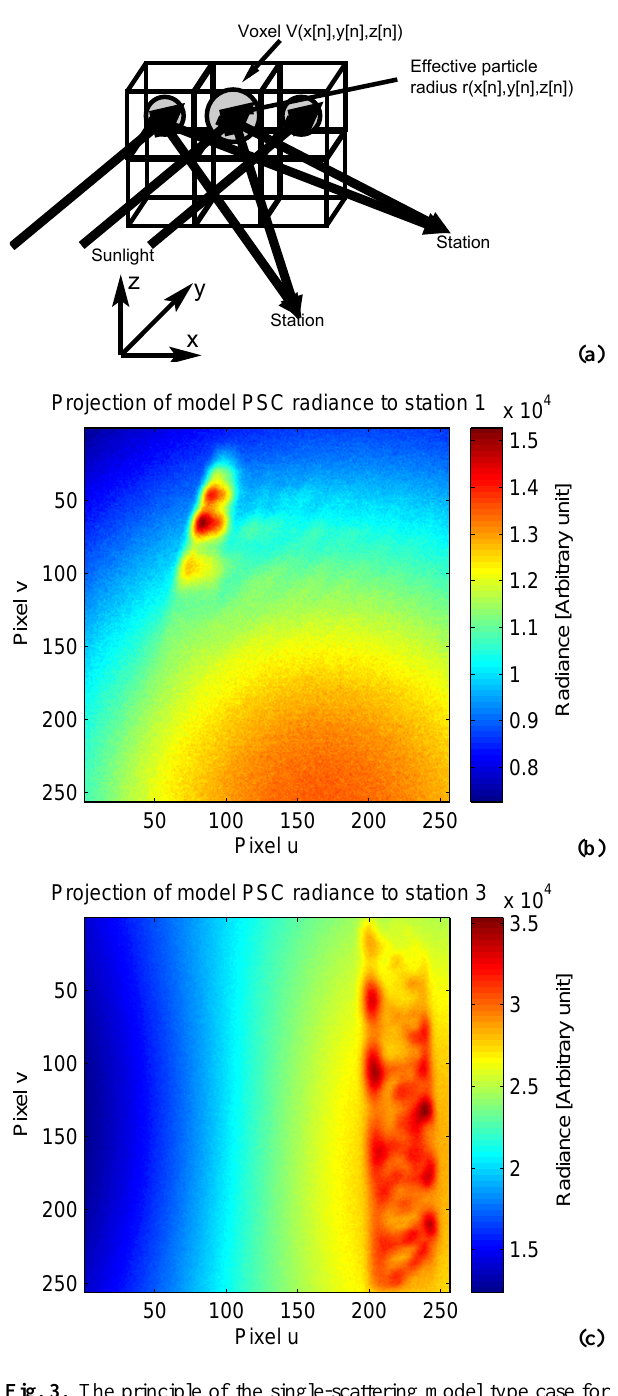
Fig. 3. The principle of the single-scattering model type case for altitude matching. Upper panel ( a ) : Outline of the model volume. Lower panels: Resulting projections to stations 1 ( b ) and 3 ( c ) by scattering from the model volumes at 5590 ± 40 ˚A, assuming sunset in the south-southwest.